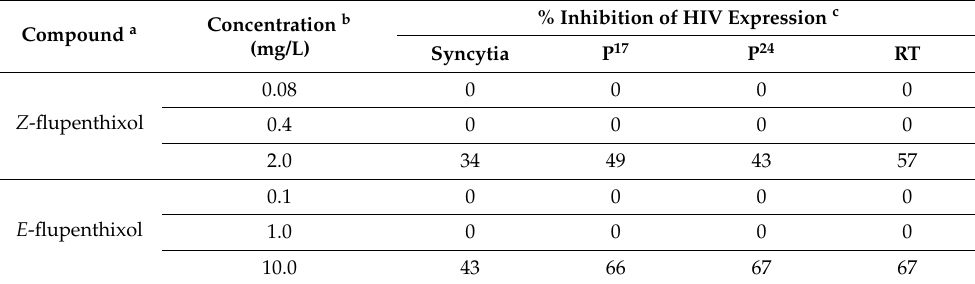
Table 11. Effect of neuroleptic drugs on HIV-1